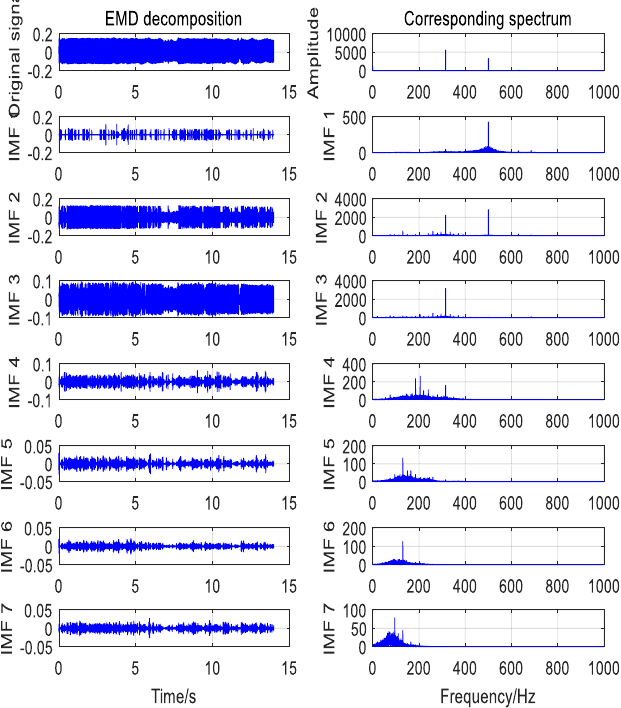
Fig. 8. Time-domain and frequency-domain diagrams of intrin- sic mode components after wavelet